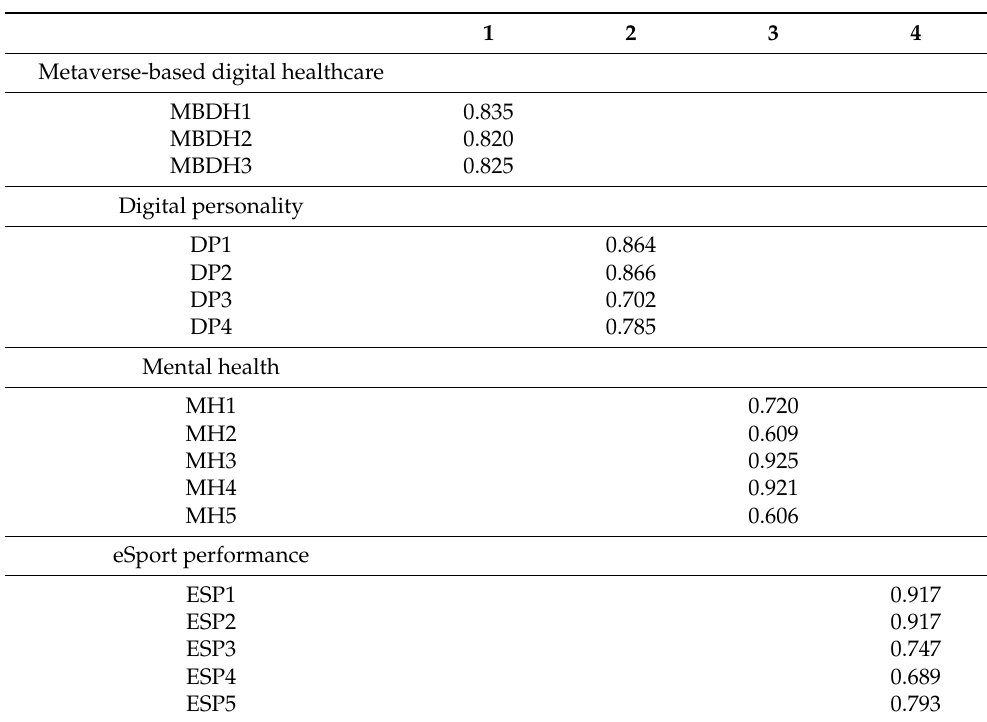
Table 4. Rotated component matrix.